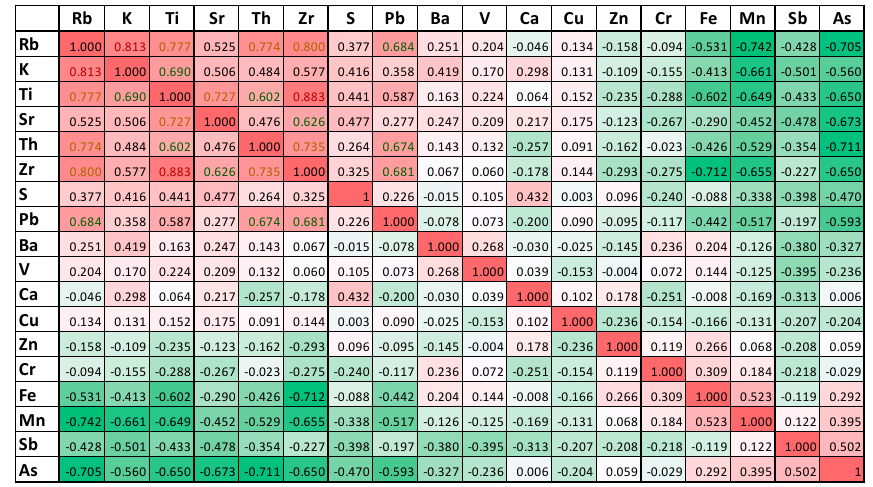
Figure 4. Pearson correlations on clr data for B horizon Group B observations, pXRF measurements. The use of colour shading and its interpretation is described in [35].